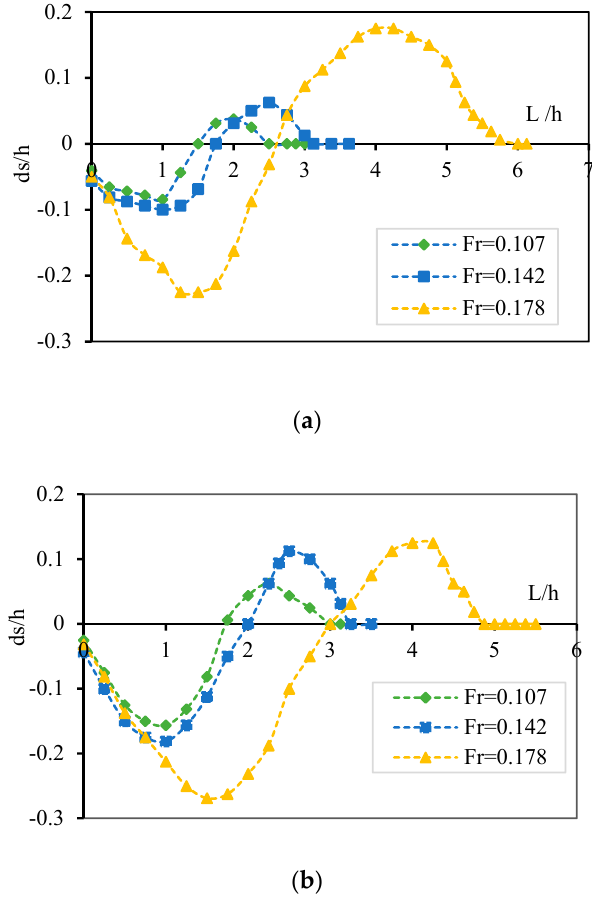
Figure 6. Comparison of the longitudinal profile of the bed for Run 10, Run 18, and Run 30: ( a ) y/W = 0.25 (left side); ( b ) y/W = 0.75 (right side).